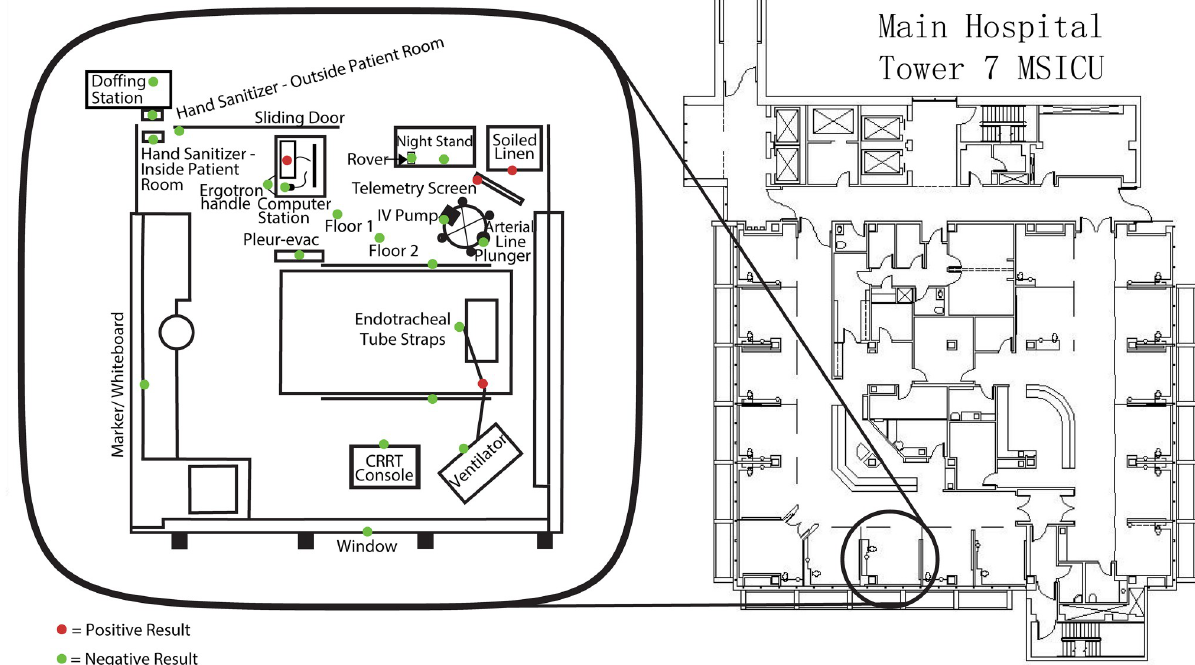
Fig 1. Representative ward room sampled by swabs for SARS-CoV-2 at the UCDMC. Positive samples are shown in red, negative samples in green. Each dot represents a single swab.